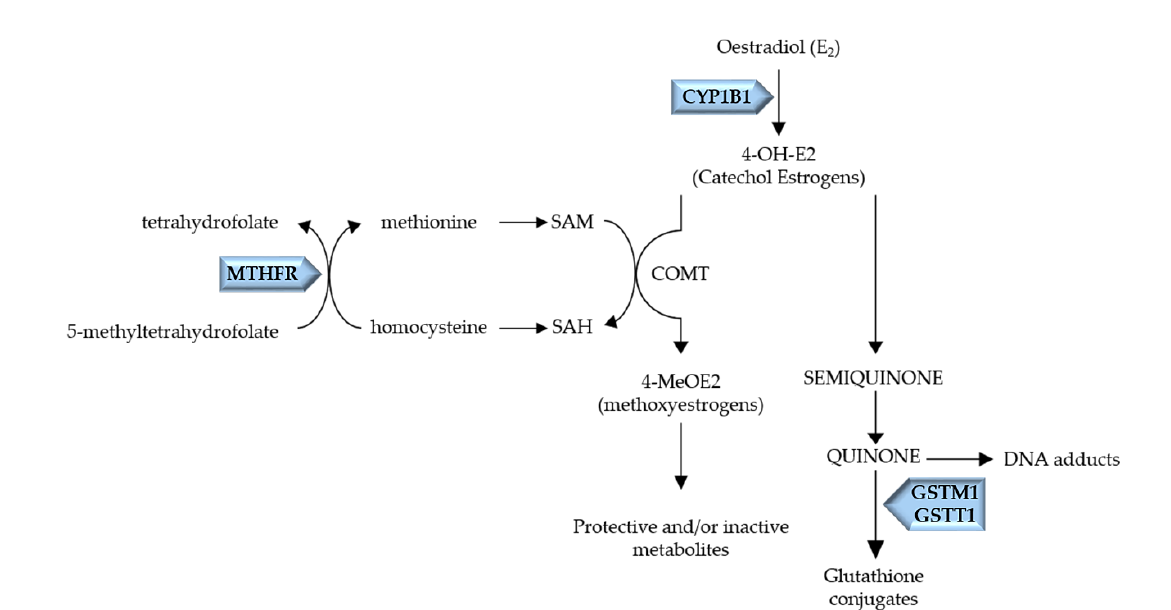
Figure 1. Schematic representation of the metabolic pathway of Oestradiol. CYP1B1, a Phase I enzyme, codified by the CYP1B1 gene, leads to 4-OH-E2 production. The Phase II enzymes, COMT, codified by the COMT gene, and GSTM1/GSTT1, codified by GSTM1 and GSTT1 genes, respectively, inactivate the estrogen catechol, semiquinone and quinone, diminishing DNA adducts formation. MTHFR, an enzyme of the folate metabolism, catalyzes 5,10-methylenetetrahydrofolate to 5-methyltetrahydrofolate, which allows the remethylation of homocysteine to methionine, a precursor of S-adenosylmethionine (SAM). SAM is the methyl donor for COMT catalyzed reactions, allowing the inactivation of catechol estrogens.